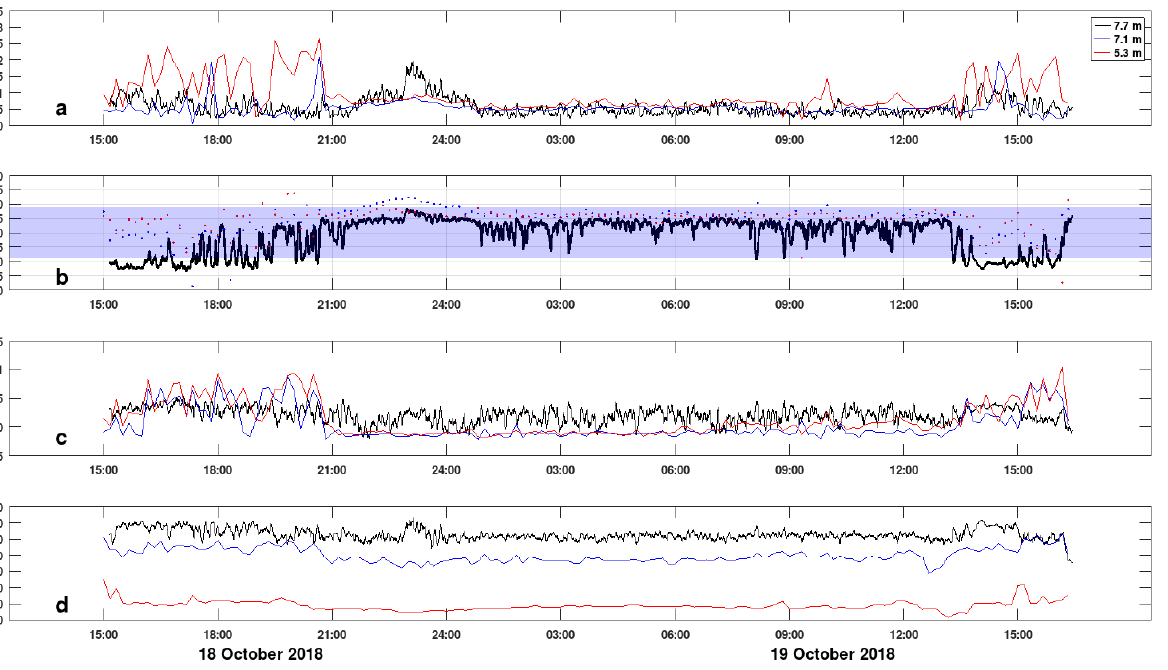
Figure 3. ( a ) Magnitude of horizontal velocities at depths 7.7, 7.1, and 5.3 m. ( b ) Direction of the horizontal velocities reported in ( a ). The blue shading corresponds to directions of the vector-recorded, near-bed flow away from the Aquadopp profiler. ( c ) Vertical velocities and ( d ) acoustic back-scatter intensities (in counts). Throughout the figure, black refers to Vector near-bed data at 7.7 m depth, while blue to data from 7.1 m and red to data from 5.3 m, both from Aquadopp depth bins.